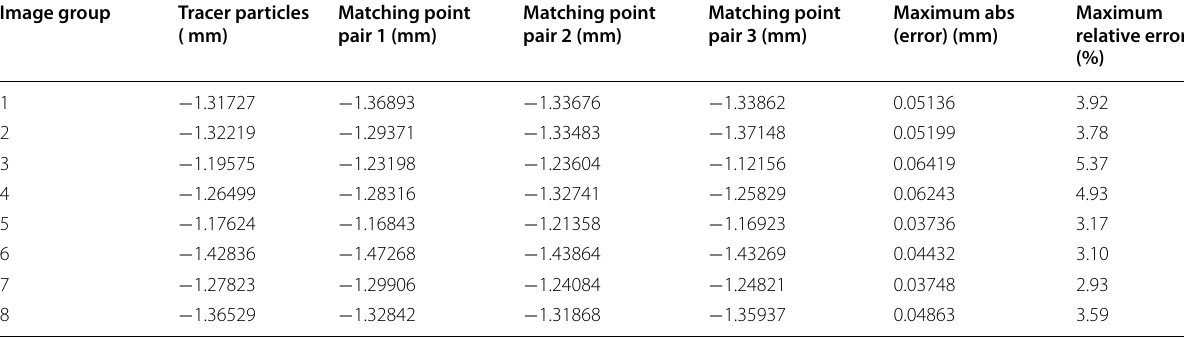
Table 4 Comparison between the tracer particle and the matching point pairs Image